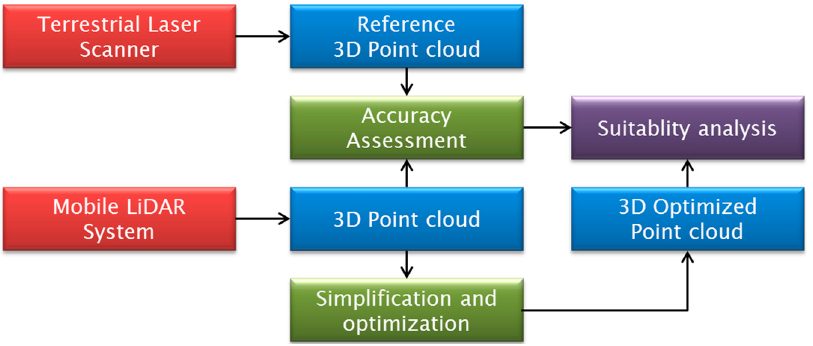
Figure 2. Pipeline for the assessment of Mobile LiDAR Systems (MLS) for Cultural Heritage recording and modeling.